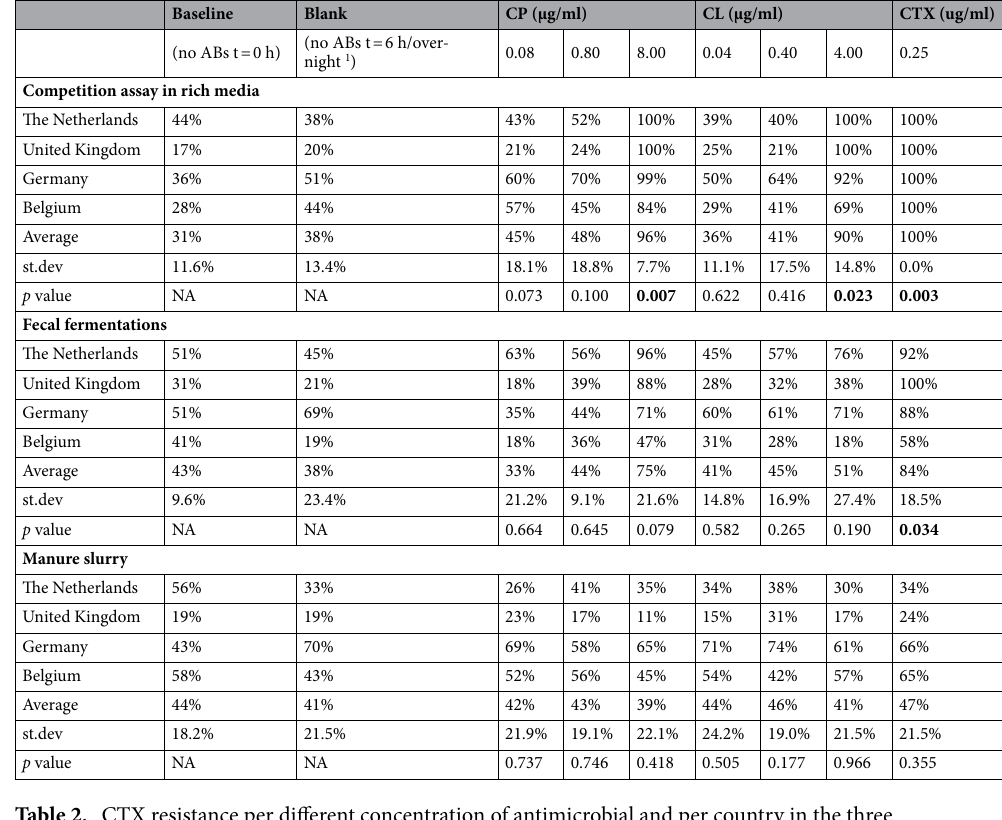
Table 2. CTX resistance per different concentration of antimicrobial and per country in the three experiments. 1 Rich media t = 6 h; fecal fermentations and manure slurry t = overnight; ABs = antibiotics; CP = cephapirin; CL = cefalonium; CTX = cefotaxime. Significant values are in [bold].